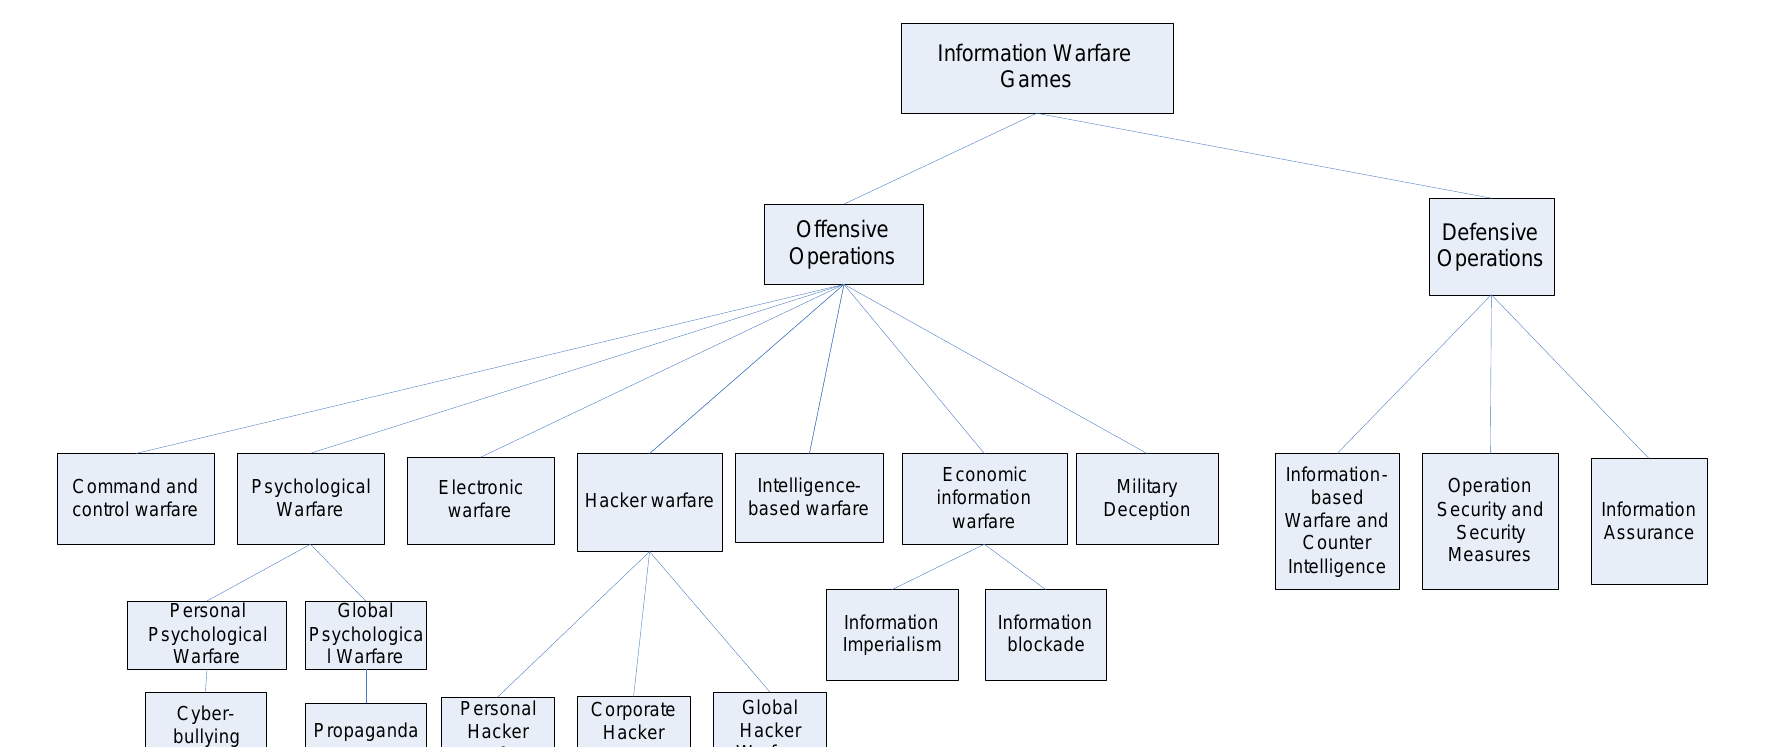
Figure 2. Framework to classify information warfare